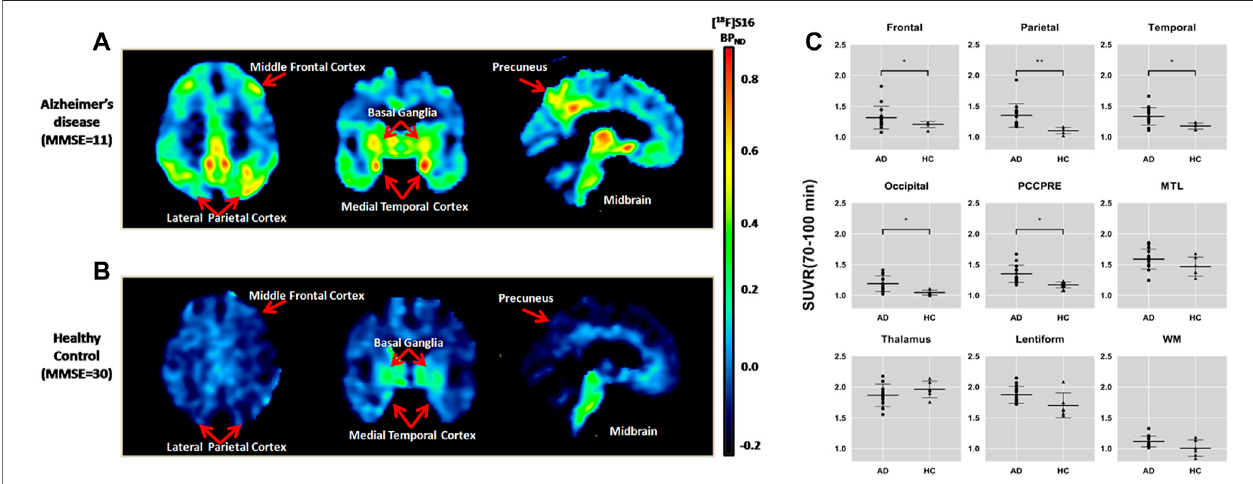
FIGURE 3 | Comparison of an Alzheimer ’ s disease patient [subject 6, Mini-Mental State Examination (MMSE) = 11] (A) and a healthy control (subject 16, MMSE = 30) (B) in the mean [ 18 F]-S16 BP ND positron emission tomography maps. The images were normalized to the Montreal Neurologic Institute space and presented as a transverse,coronal,andsagittalplane.Boxplotofstandardizeduptakevalueratio(SUVR;70 – 100 min)ofeachdiagnosisgroupfordifferentbrainregions (C) .Boxplotof SUVR (70 – 100 min) of each diagnosis group for different brain regions.* p < 0.05, ** p < 0.01.